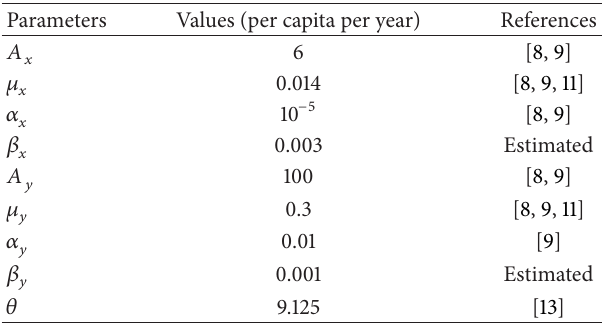
Table 1: Values of